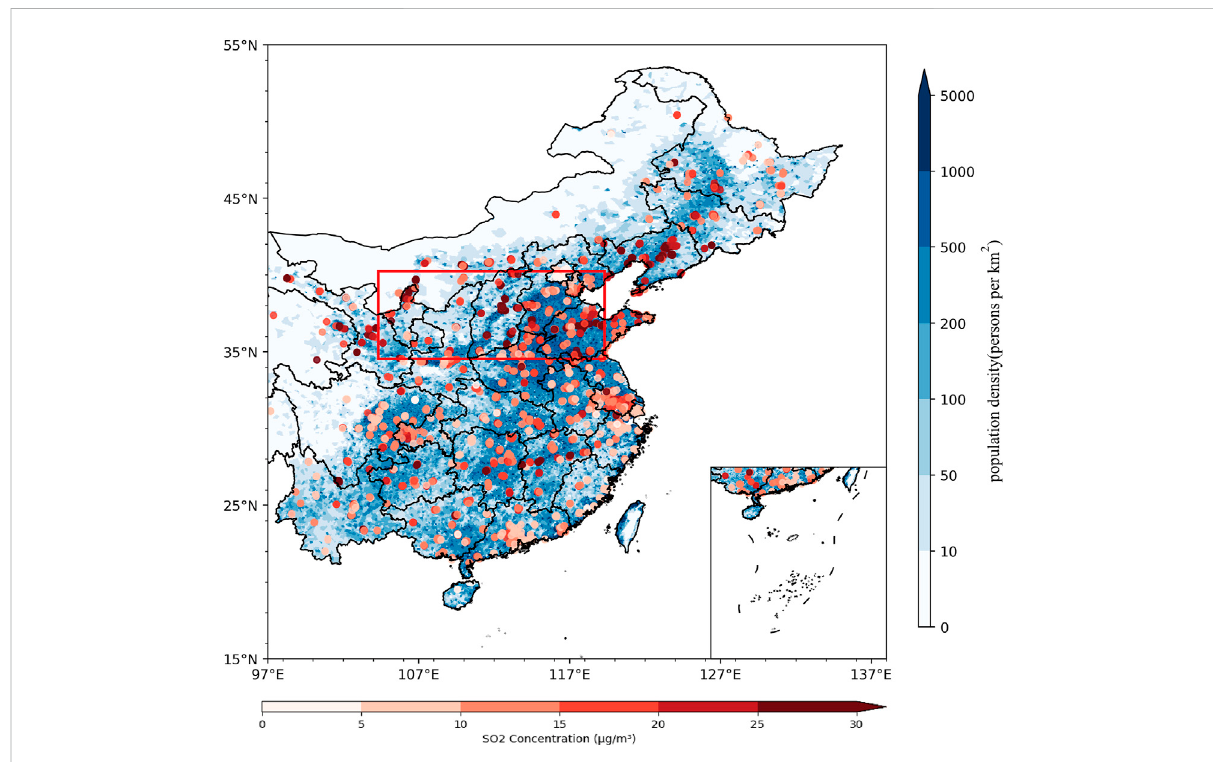
FIGURE 1 Distribution map of SO 2 monitoring stations. The color of the stations indicates the hourly average SO 2 concentration of the ground observation site. The bottom map shows the population density distribution. The area in the red box in the fi gure is North China, which is the most polluted region in eastern China.